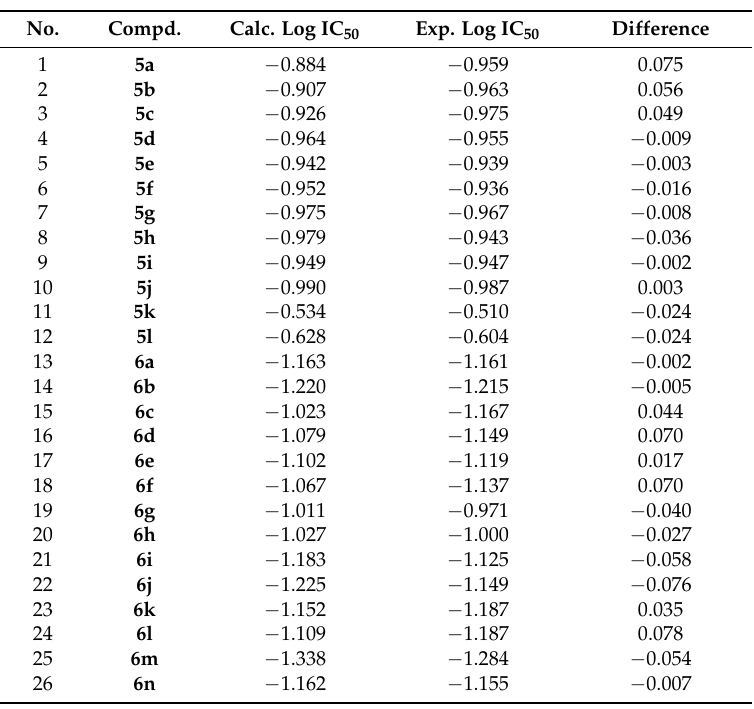
Figure 2. The comparison between experimental log IC 50 and predicted log IC 50 . Table 3. The difference between the experimental log IC 50 and predicted log IC 50 .